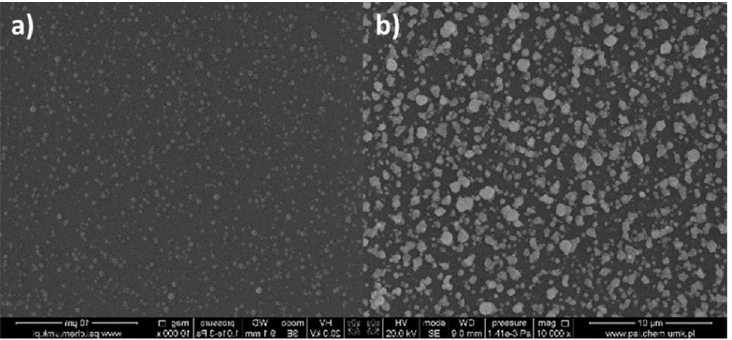
Figure 24. SEM image of [Cu 2 (EtNH 2 ) 2 (µ-O 2 CC 2 F 5 ) 4 ] ( 2 )/Si, immersion time 30 s, after heating.